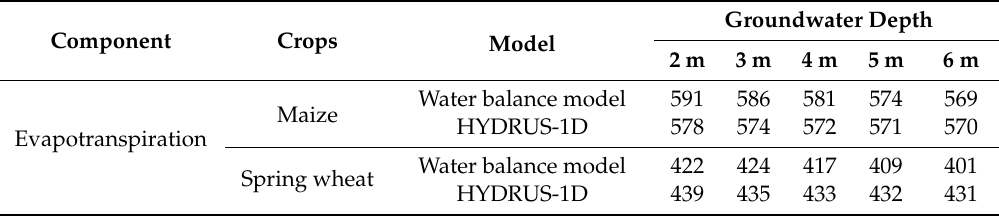
Figure 5. Results of evapotranspiration (ET) for summer maize under the conditions of groundwater depths at 2 m ( a ), 3 m ( b ), 4 m ( c ), 5 m ( d ) and 6 m ( e ), and for spring wheat under the conditions of groundwater depths at 2 m ( f ), 3 m ( g ), 4 m ( h ), 5 m ( i ) and 6 m ( j ) (GW means groundwater depth and WBM means water balance model). Table 5. Results of evapotranspiration, deep percolation and groundwater recharge under different groundwater depths calculated by water balance model and HYDRUS-1D (unit: mm/growing season).